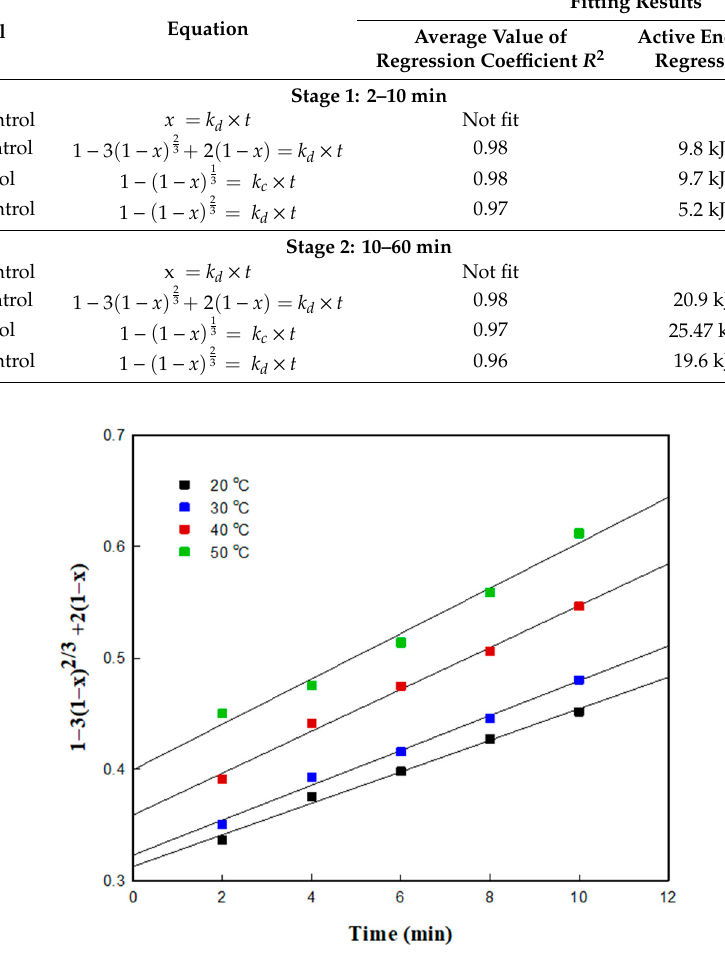
2 Figure 8. Plot of [ 1 − 3 ( 1 − x ) 3 + 2 ( 1 − x )] versus leaching time (2–10 min) at different temperatures .